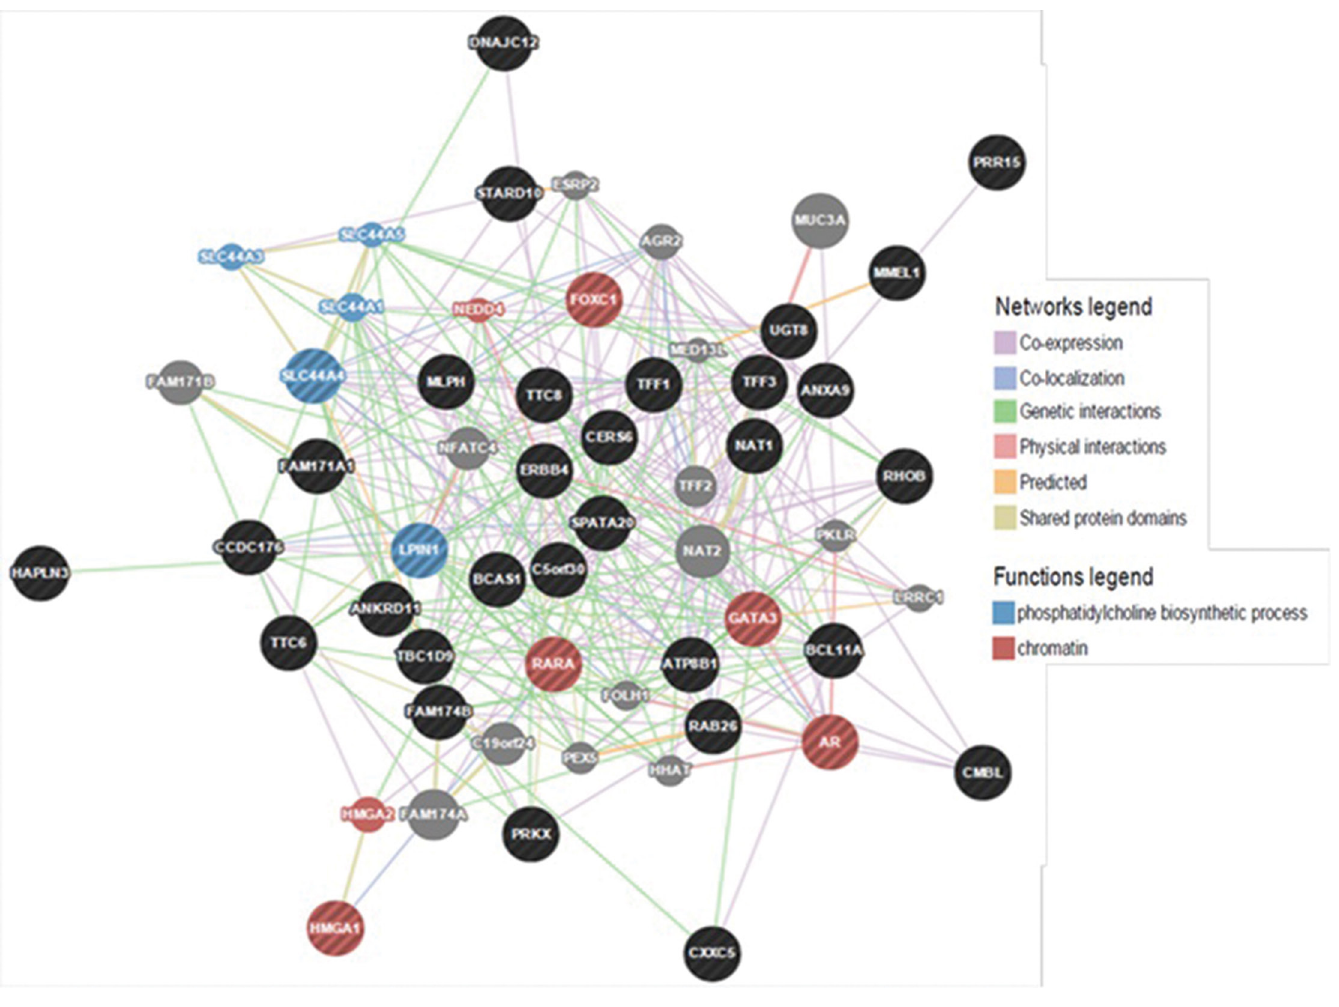
Figure 4. TNBC signature’s gene network. The left side represents the gene network from the TNBC signature. Each black circle signifies a gene from the TNBC signature, while gray ones symbolize other genes not included in TNBC signatures. Lines denote a relationship be- tween circles (genes), and line thickness correlates to relationship intensity. The right side shows color codes for lines that connect circles (genes) and functions of some genes from the gene network. Main functions are in blue (phosphatidylcholine biosynthetic process) and red